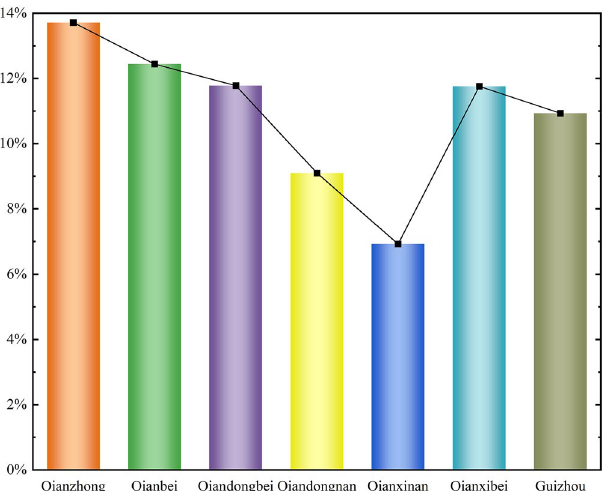
Figure 6. Average reclamation rate by district.